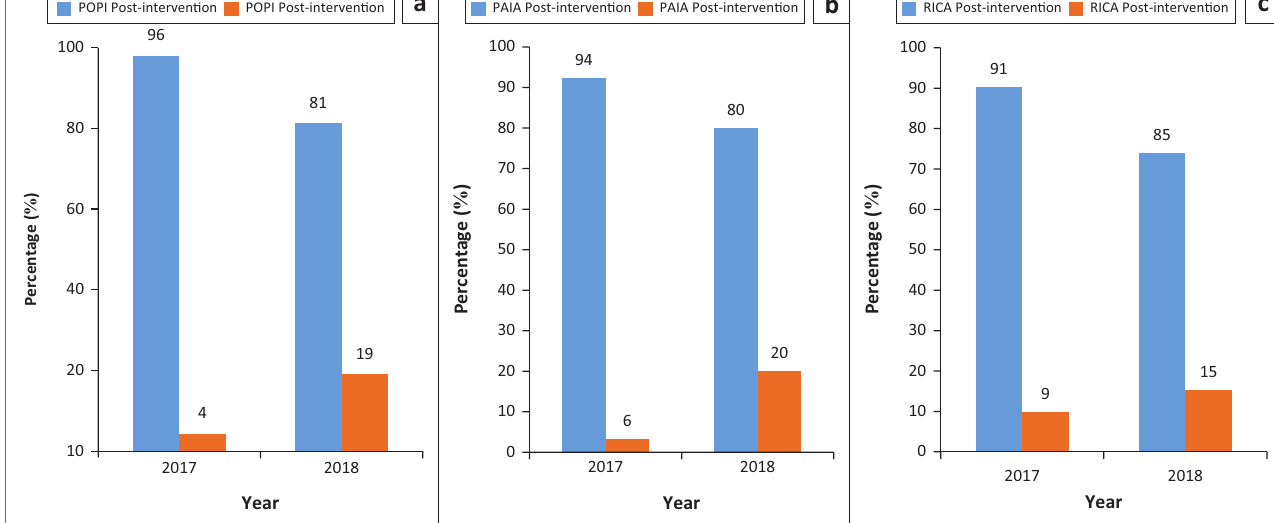
FIGURE 5: Post-intervention responses to acronyms Protection of Personal Information, Promotion of Access to Information Act and Regulation of Interception of